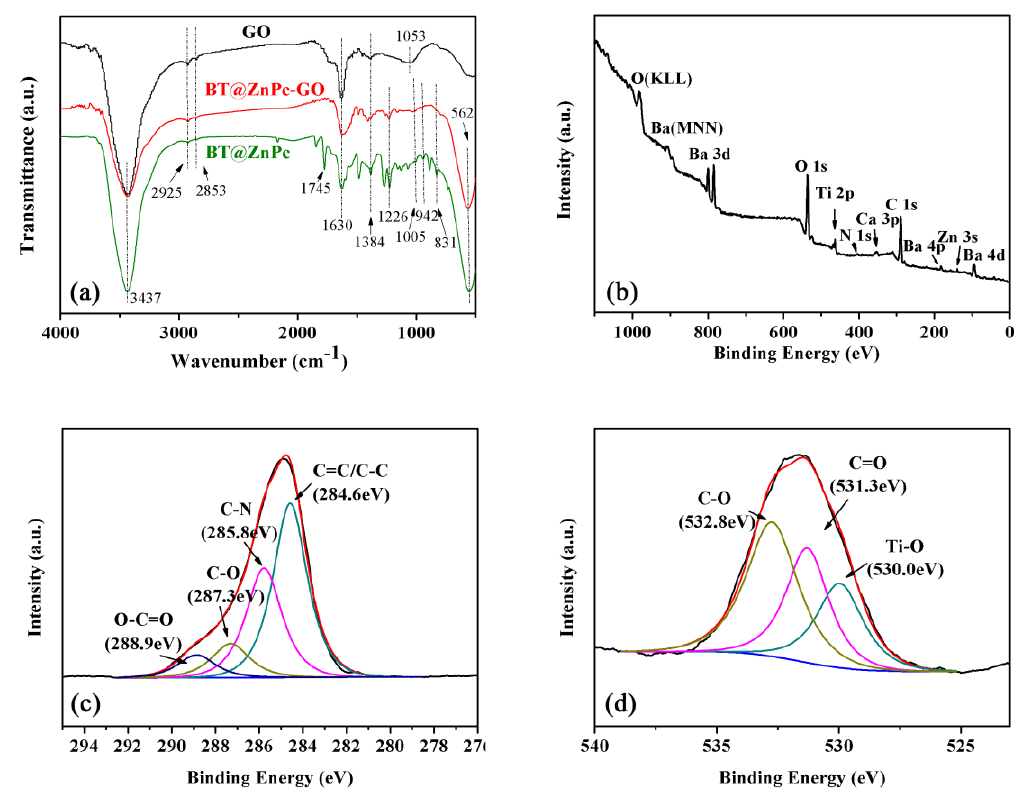
Figure 4. ( a ) Fourier transform infrared spectroscopy (FTIR) spectra of GO, BT@Znpc-GO-1